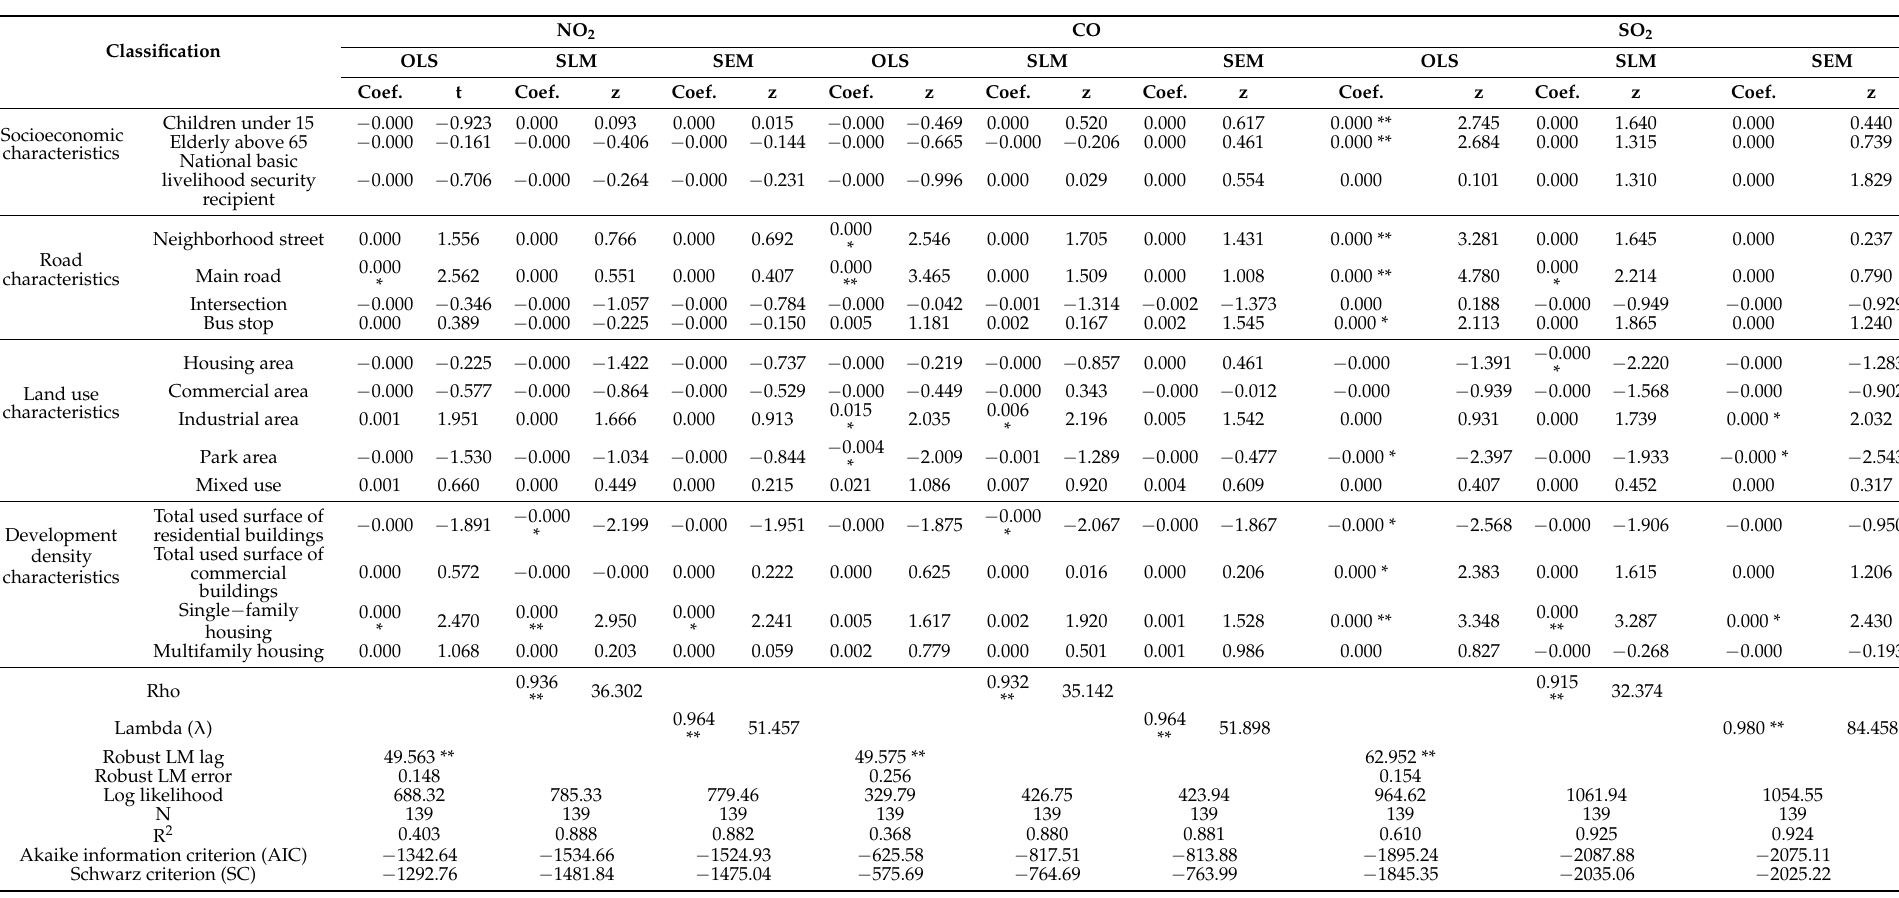
Table A2. Results of spatial regression